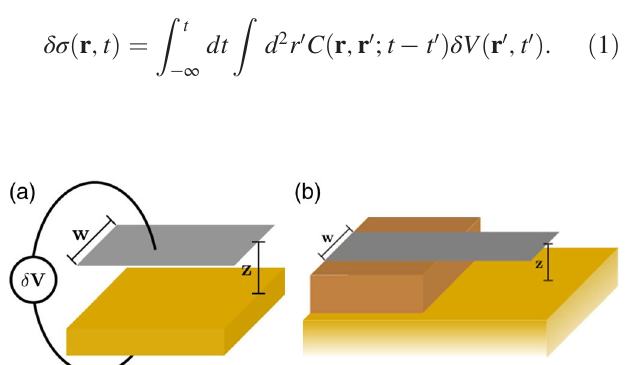
FIG. 1. (a) Ideal system under consideration. A parallel plate capacitor connected by a wire supporting voltage fluctuations δ V . One of the plates can be a graphene ribbon with a width w above a thick metallic substrate separated by a distance z . The capacitor system is assumed to be in an environment of air with ϵ ≈ 1 . (b) Experimentally realistic setting. The wire is represented by a metallic connection between the “ bottom ” metal plate and the “ top ” graphene